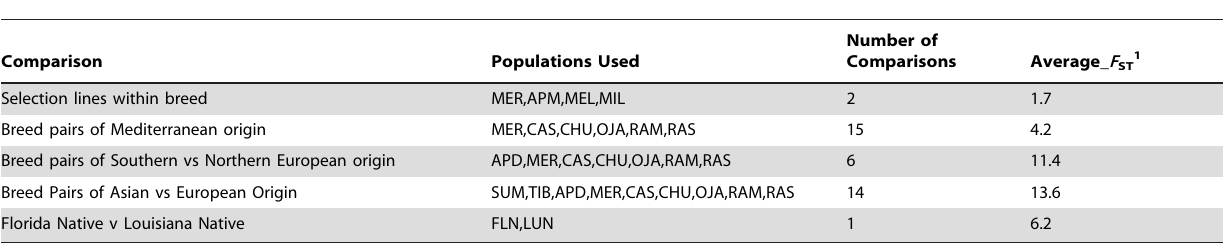
Table 2. Average F ST for different population comparisons.